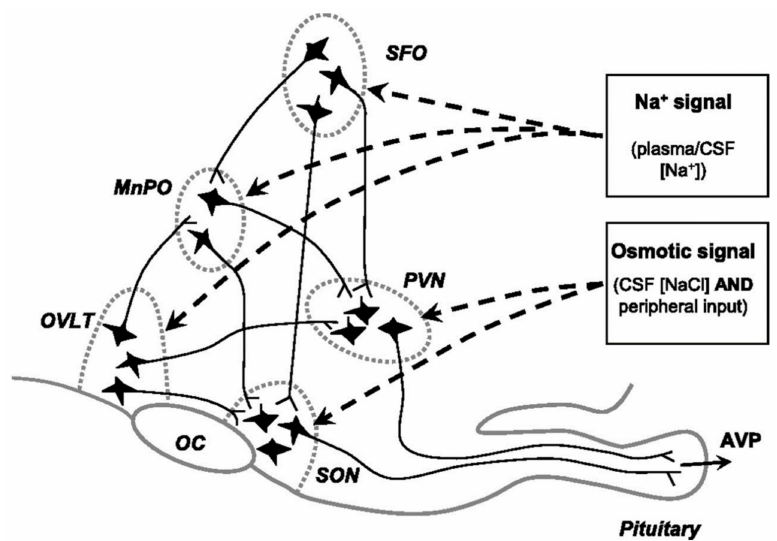
Figure 2. The map of osmoreceptors in the brain: The osmoreceptor’s location in brain regions such as SFO, OVLT, MnPO, and SON. When stimulated by changes in osmotic pressure or sodium levels, the osmoreceptor activates SON, releasing AVP to regulate water reabsorption and stimulate thirst via OVLT and SFO. Na + and osmotic signals are critical factors that regulate osmoreceptor activity and AVP release, maintaining body fluid